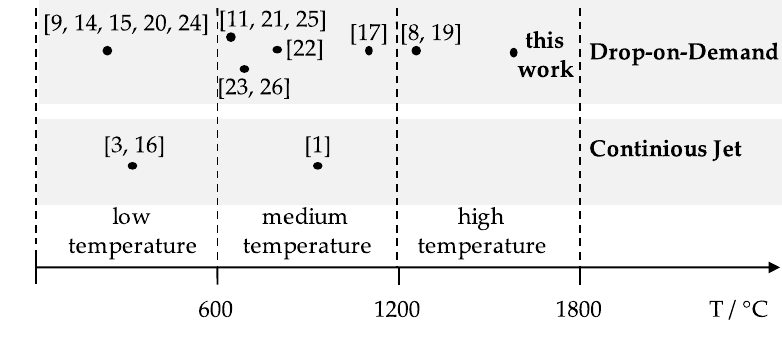
Figure 1. Overview of temperature ranges used in various droplet generation techniques [1,3,8,9,11,14–17,19–26].